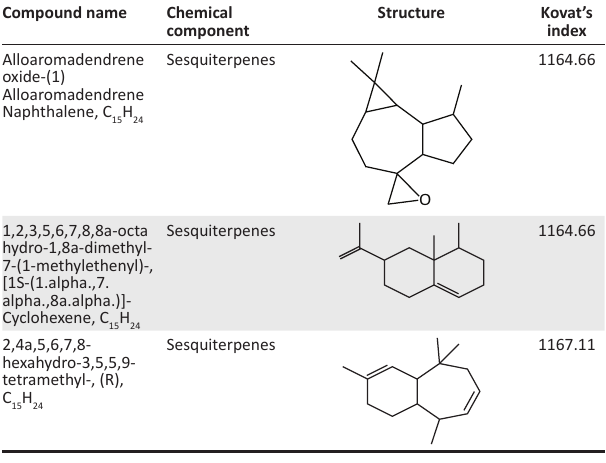
TABLE 2 (Continues): Kovat’s index of chemical compounds and structural formula for the solvent-free extraction method. Chemical compound Chemical